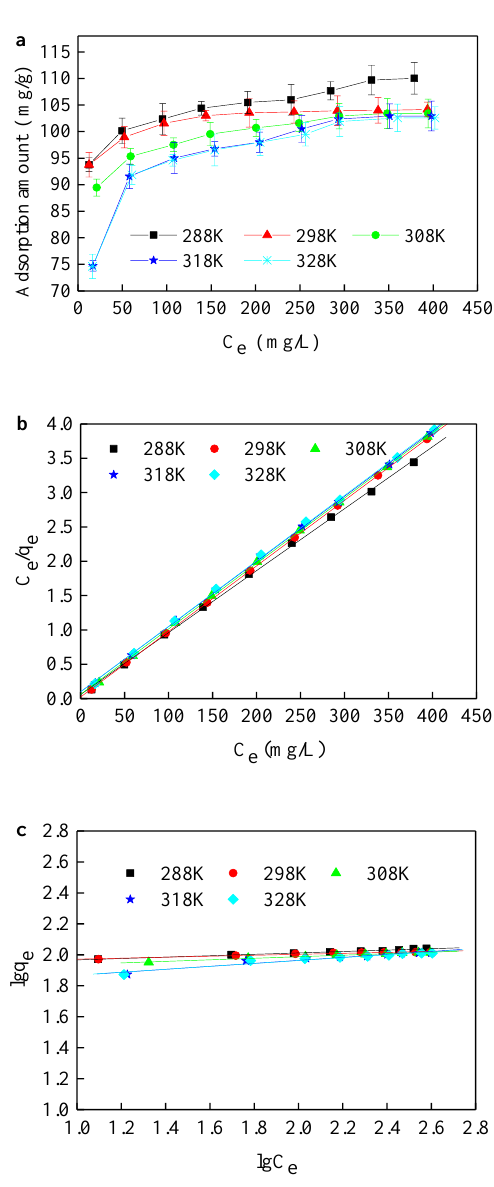
Figure 6. ( a ) Adsorption isotherm at various temperatures; ( b ) Langmuir linear fitting of experimental data at various temperatures; ( c ) Freundlich linear fitting of experimental data at various temperatures. To ensure the adsorbed saturation, the adsorption test was conducted with 200 mg / L Acid Orange II and 2 g / L modified sepiolite under an oscillation rate of 180 r / min and an initial pH value of 1 for at least 10 h at a certain temperature in a constant temperature oscillating box. Table 3. Langmuir Linear Fitting and Freundlich Linear Fitting Results of Modified Sepiolite Adsorption.